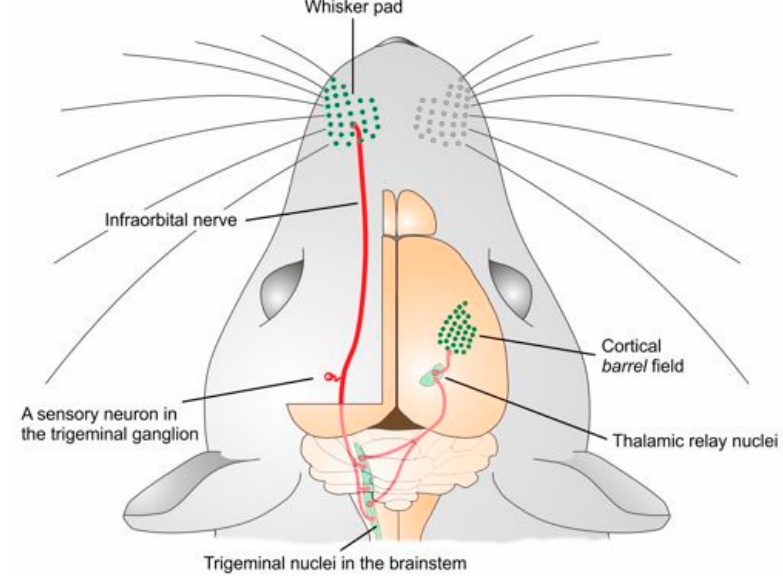
Figure 1. Schematic drawing of the trigeminal somatosensory pathway. Each vibrissal follicle in the whisker pad is innervated by several peripheral endings of primary afferents. The somata of primary sensory neurons are located in the trigeminal ganglion; the central projections of these neurons distribute their terminal arbors in the trigeminal nuclei in the brain stem. These nuclei project densely and in a highly organized spatial pattern to the contralateral thalamus, which, in turn, projects to the somatosensory cortex. Somatosensory information from other bodily regions is collected by primary sensory neurons in the dorsal root ganglion, transferred to the spinal cord and lower brain stem, and eventually projected to the thalamus and the cortex in a comparable manner (not shown).